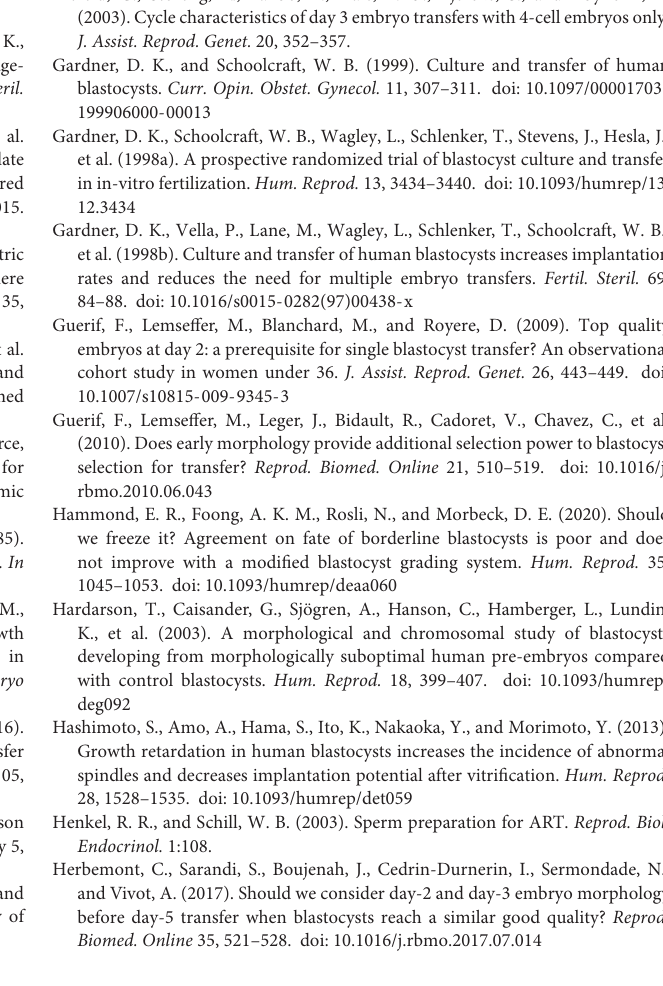
FIGURE S1 | The comparison of age between total and their selected group (A) . The age between patients with and without live births were compared in the BB group (B) , BC group (C) , and CB group (D) . Total patients (black), selected patients with blastocyst expansion degree ≥ 4 (magenta), selected patients with day 5 frozen (red), selected patients with day 3 cell ≥ 8 (blue), and selected patients with day 5 frozen combined with day 3 cell ≥ 8 (green) are shown as boxplots in panels (A–E) . The difference between total patients and selected patients is compared using Student’s t -test or one-way